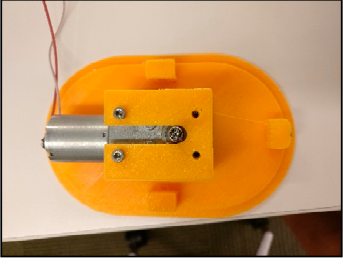
Figure 2. Base of the open source nutating mixer printed with PLA and showing the 12 V 25 RPM DC geared motor mounted in place.